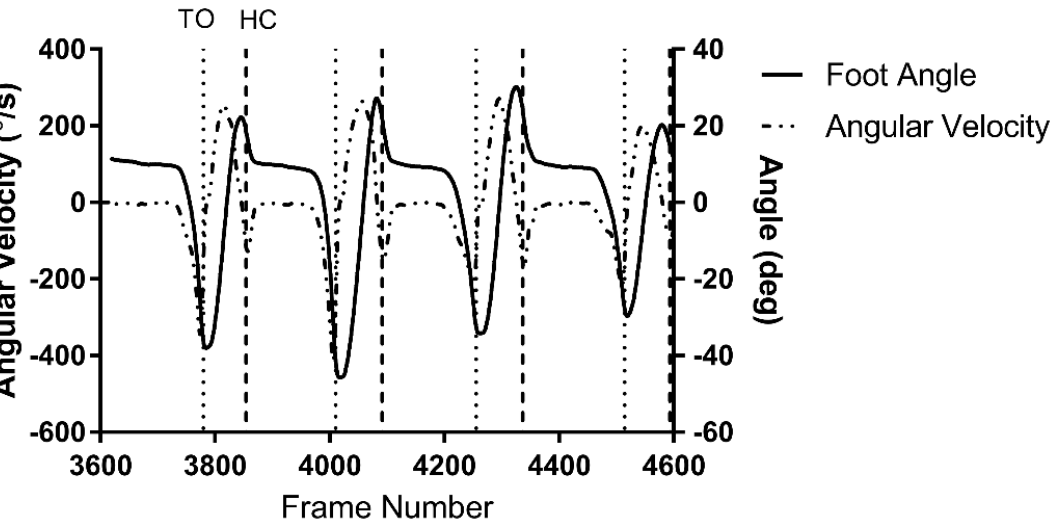
Figure 5. Changes in foot angle and its angular velocity over sample steps with toe off (TO) and heel contact (HC) times shown as dashed vertical lines. The foot angle signal shown does not start at 0 ◦ . This offset angle is the result of toe markers and heel marker not being at the same height.